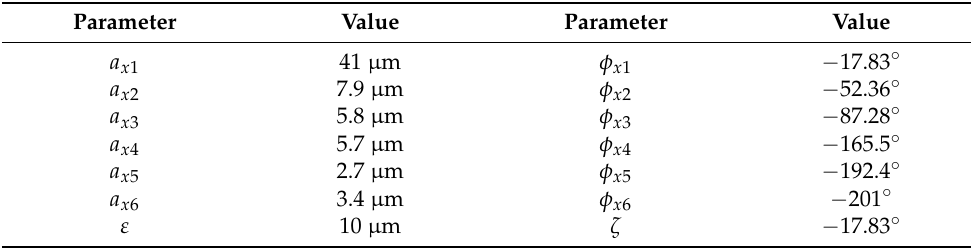
Figure 15. Frequency characteristics of displacement sensor in x -direction. Table 2. Parameters of mass unbalance and sensor